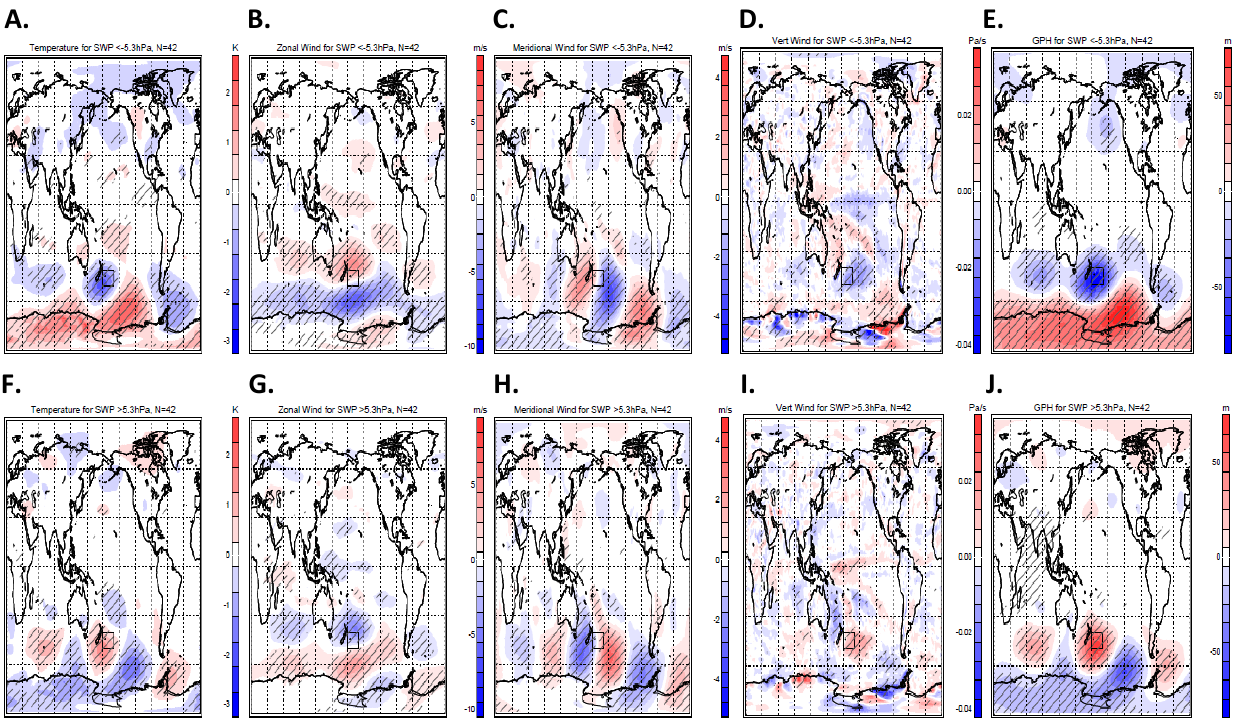
Figure 7. Composites of deseasonalised monthly ERA-Interim reanalysis fields at 700hPa for surface pressure 10th percentile (negative) and 90th percentile (positive) anomalies in the southwestern Pacific (SWP) Ocean (180–200 ◦ E, 45–55 ◦ S) for 1979–2012 (Dee et al., 2011). Shown are temperature (a, f) , zonal wind speed ( b, g ; positive = eastward) and meridional wind speed ( c, h ; positive = northward), vertical pressure wind ( d, i ; positive = downward) and geopotential height (e, j) . The SWP surface pressure anomaly threshold and the number of months ( N ) contributing to each composite are shown at the top of each panel. Hatched areas denote areas of statistical significance (95%